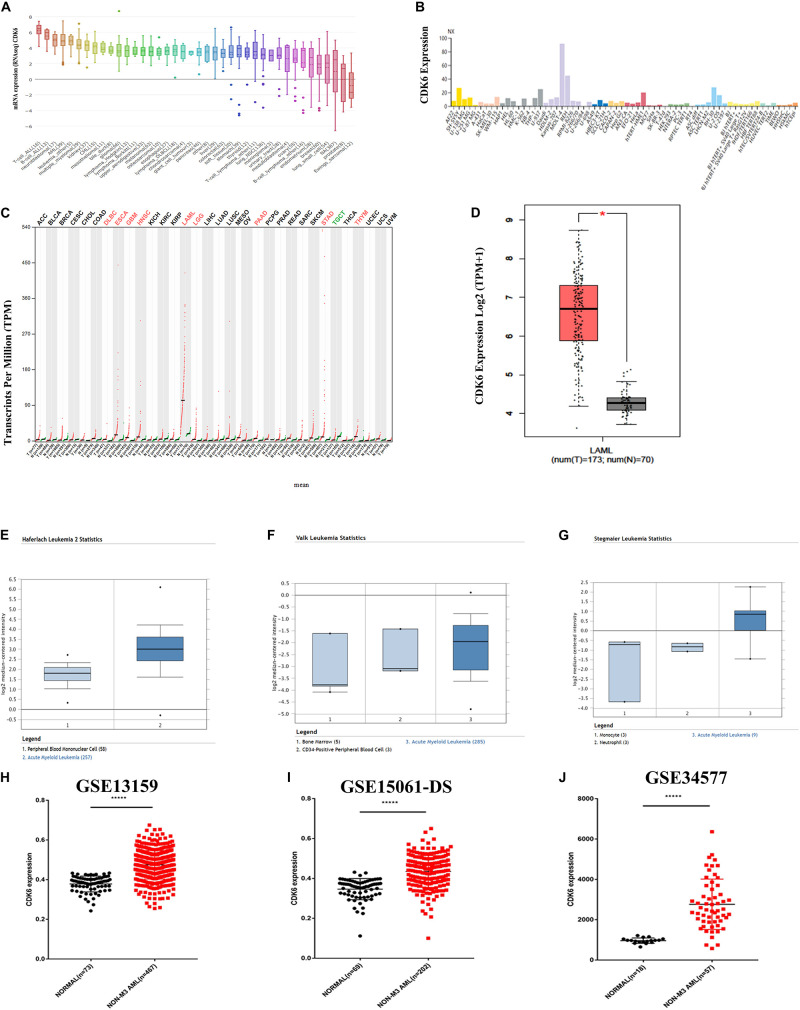
CDK6 overexpression in non-APL AML in the public database. (A) The expression of CDK6 in 40 types of human cancer cell line in the Cancer Cell Line Encyclopedia (CCLE) database. (B) The expression of CDK6 in human cancer cell lines in Human Protein Atlas (HPA) database. (C) The expression of CDK6 in 33 types compared with normal subjects in Gene Expression Profiling Interactive Analysis (GEPIA) database. (D) The expression of CDK6 in AML patients (n = 173) from TCGA and normal (n = 70) from GTX database by using (GEPIA) (p < 0.01). (E–G) In Haferlach leukemia2, Valk Leukemia, and Stegmaier leukemia statistics, CDK6 was overexpressed in AML patients than normal with a fold change = 2.388, p = 2.88E-30, fold change = 1.786, p = 0.025 and fold change = 3.179, p = 0.011, respectively. (H) The expression levels of CDK6 mRNA in non-APL AML patients(n = 467) compared with the normal samples (n = 73) (mean ± SEM level: 0.4748 ± 0.003325 vs. 0.3783 ± 0.004646, p < 0.0001) in GSE13159. (I) The expression level of CDK6 mRNA in non-APL AML patients (n = 202) compared with the normal samples (n = 69) (mean ± SEM level: 613.6 ± 30.5 vs. 253.2 ± 12.21, n = 69, p < 0.0001) in GSE15061-DS. (J) The expression level of CDK6 mRNA in non-APL AML patients (n = 57) compared with normal (n = 18) (mean ± SEM level: 961.7 ± 31.09 vs. 961.7 ± 31.09, p < 0.0001) in GSE34577.